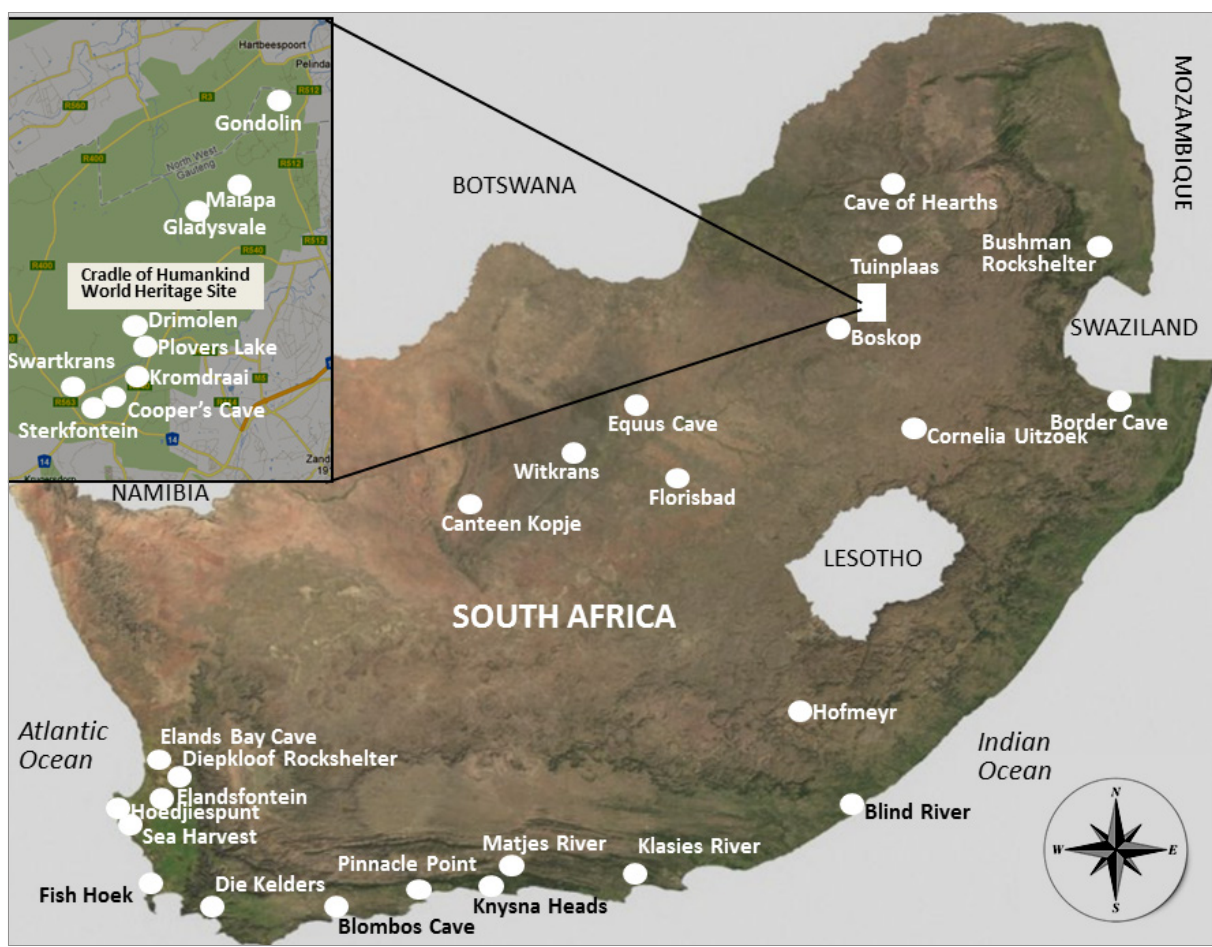
Figure 1: South African Pleistocene sites with Homo